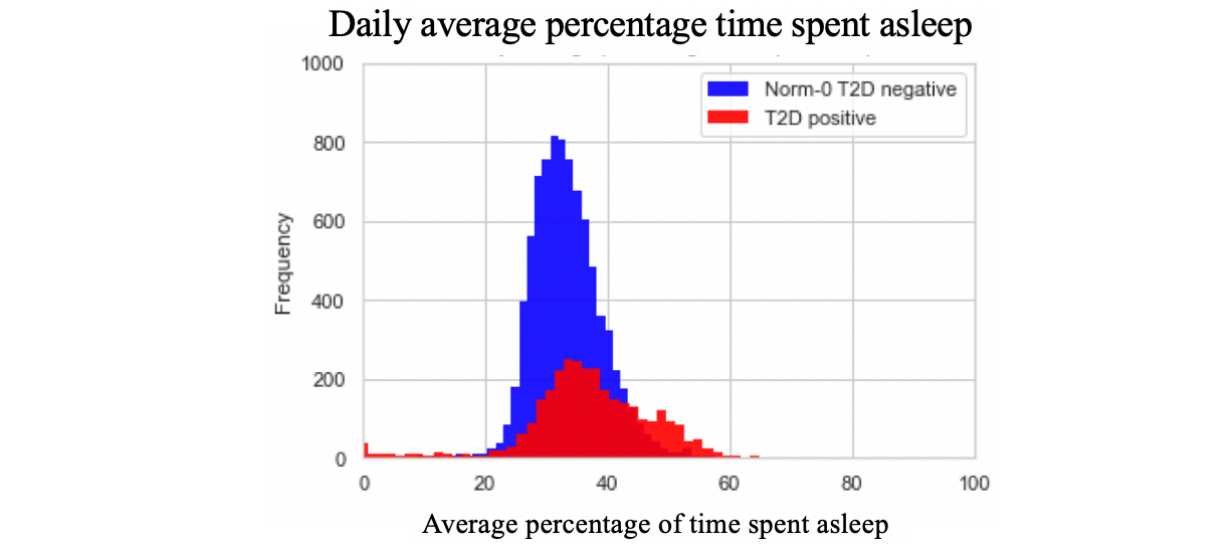
Figure 4. Histogram for daily average percentage times spent asleep.